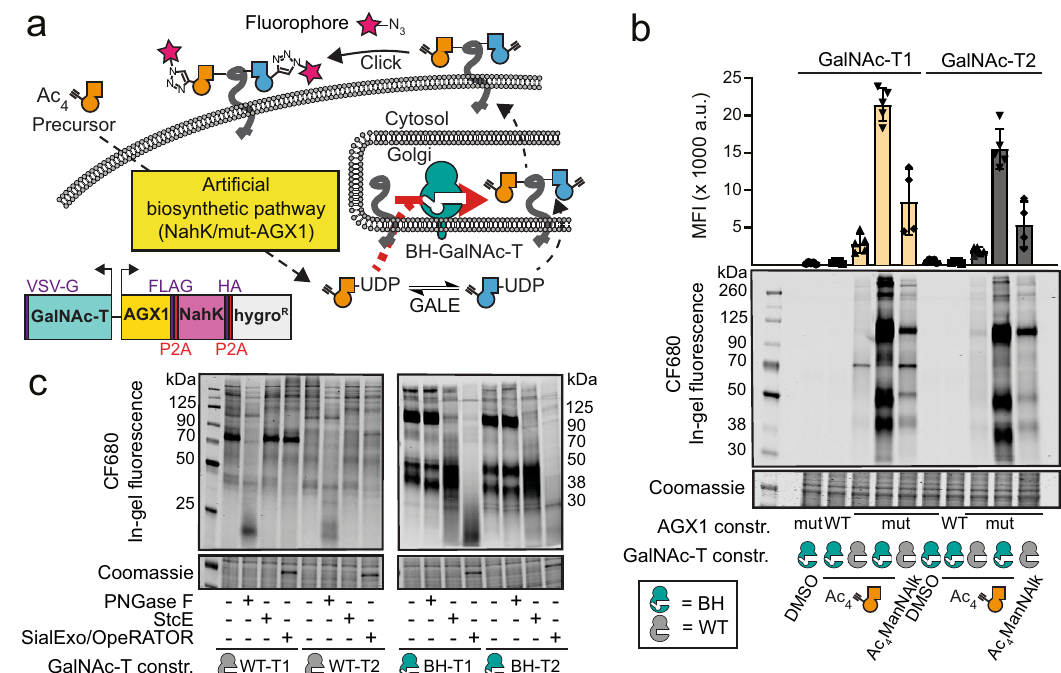
Fig. 4 | Enhancement of programmable glycoprotein tagging by expression of BH-GalNAc-Ts. a Strategy of expanding glycoprotein tagging to include O-GalNAc glycans.ExpressionofBH-GalNAc-Tsselectivelyengineeredtoaccommodatebulky chemical tags enhances O-GalNAc tagging in cells expressing NahK/mut-AGX1. b Evaluation of tagging ef fi ciency by feeding transfected K-562 cells with either DMSO, 1 μ M Ac 4 GalN6yne or 2 μ M Ac 4 ManNAlk. Tagging was analysed by in-gel fl uorescence and quanti fi cation by densitometry. Data are depicted as individual